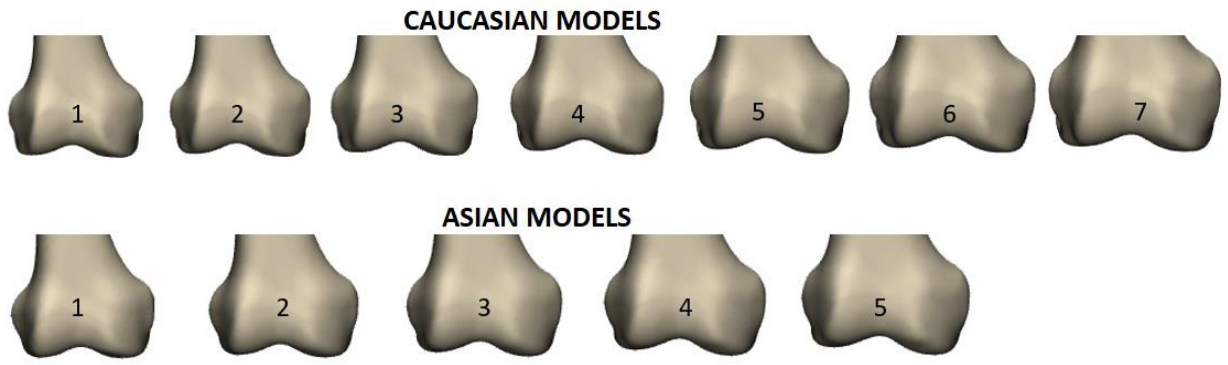
Figure 1. Generated Caucasian and Asian bone models .